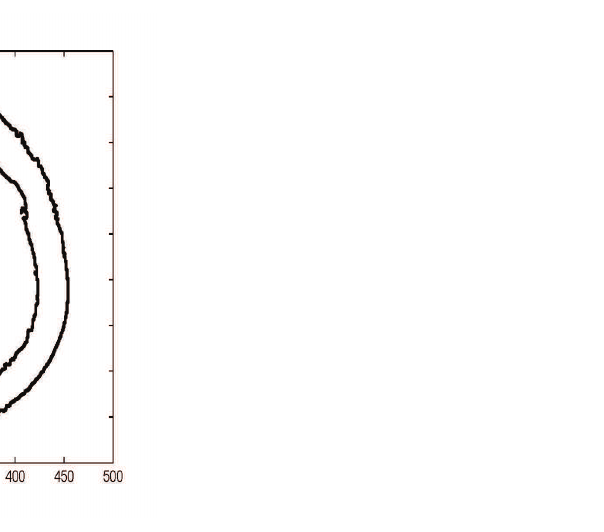
Figure 20. Construction of fractured part curve using B-spline curves with three segments.